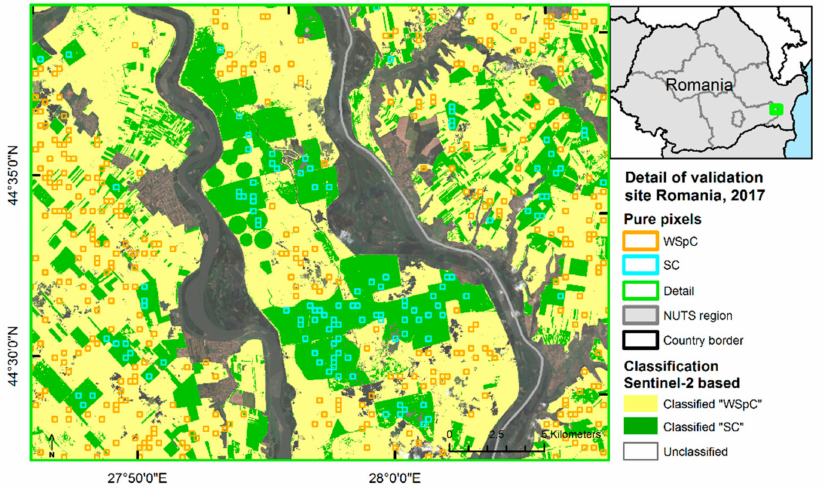
Figure 8. Details of the validation site in Romania: pure pixels (250 m spatial resolution) overlaid on the Sentinel-2-based